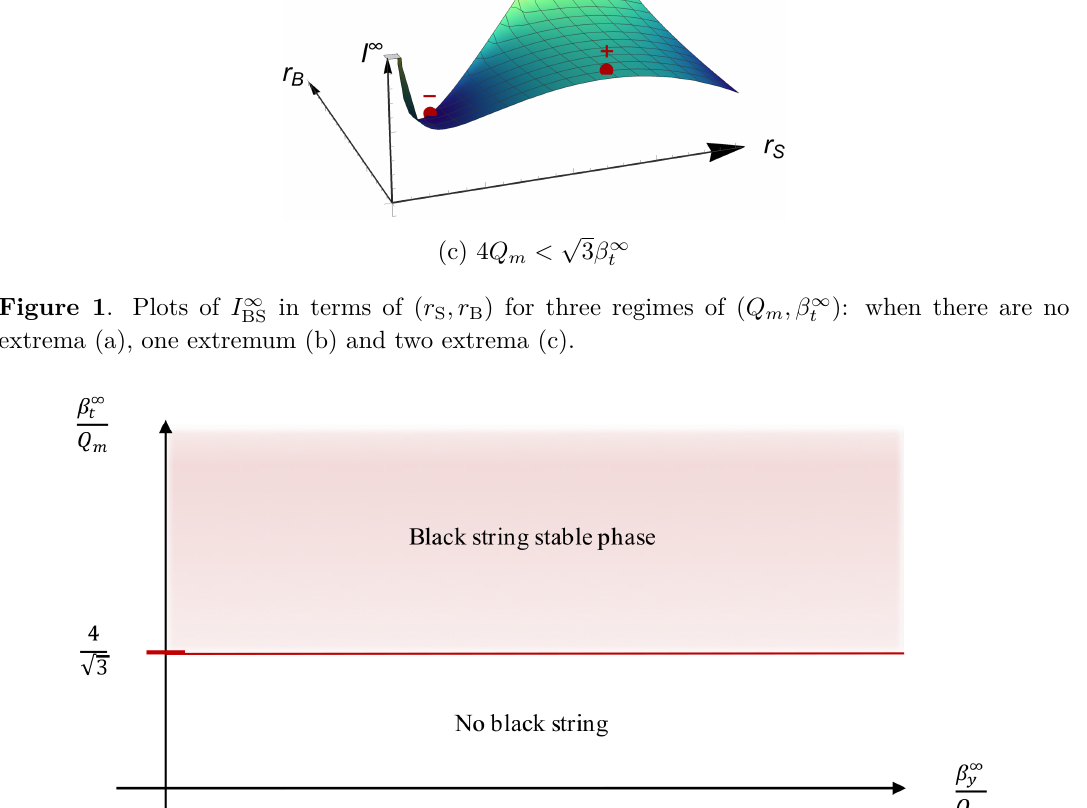
) : when there are no ∞ m , β t